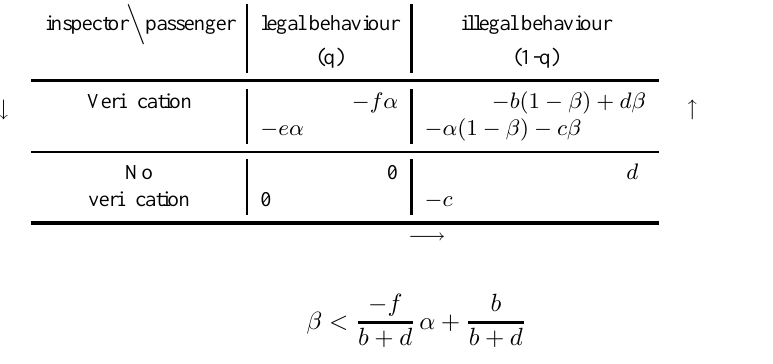
Table 3. Normal form of the two person game between a State (inspectee) and the verification authority (inspector). False alarms occur with probability (cid:11): The arrows indicate the preference directions of the two players if (3.5) is fulfilled. (cid:0)